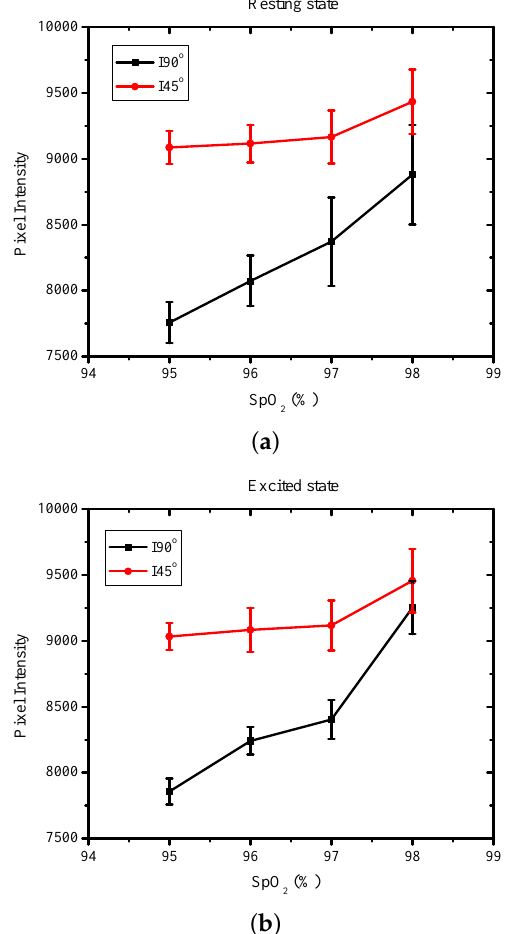
Figure 7. The variations in the pixel intensity I 90 ◦ and I 45 ◦ for varying SpO 2 levels in ( a ) resting state and ( b ) excited